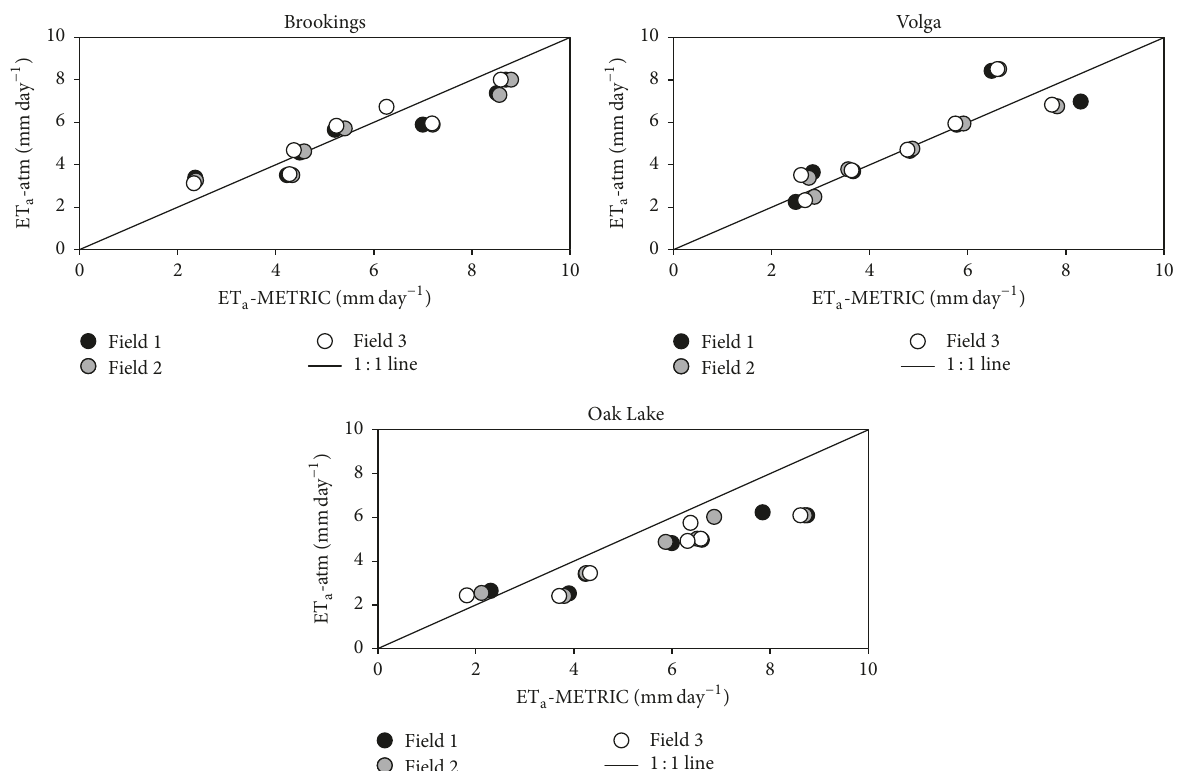
-METRIC and ET -atm at three sites and nine corn fields in eastern South Dakota for the 2016 growing a a